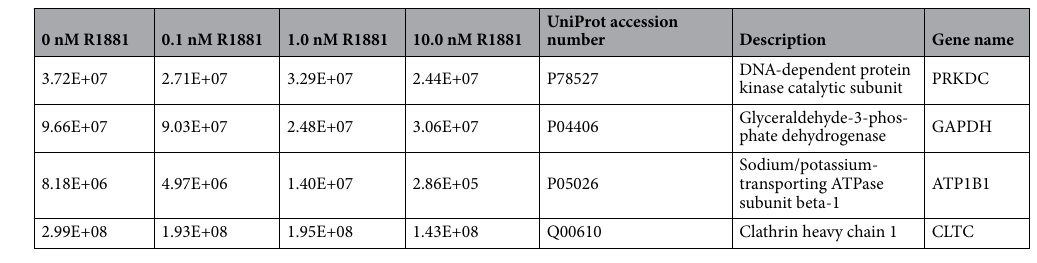
Table 1. Spectrum mill protein quantification. Total protein abundance after samples were normalized to externally spiked bovine serum albumin.